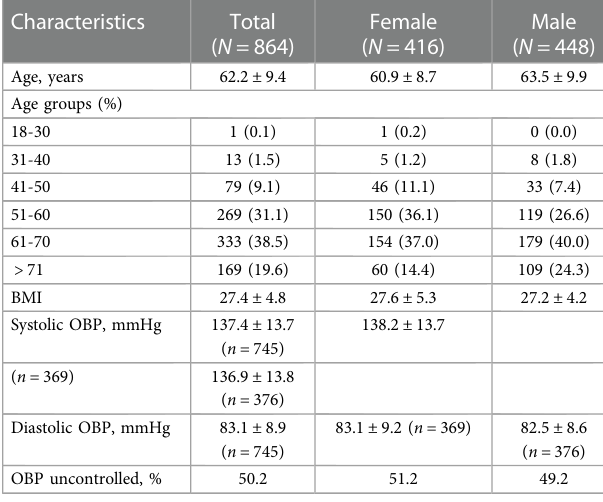
Age, BMI, systolic and diastolic OBP values are expressed as mean±SD. BMI, body mass index; OBP of fi ce blood pressure. Uncontrolled OBP: systolic BP ≥ 140 mm Hg and/or diastolic BP ≥ 90 mm Hg. TABLE 4 Blood pressure at baseline and follow-up of users with self- reported